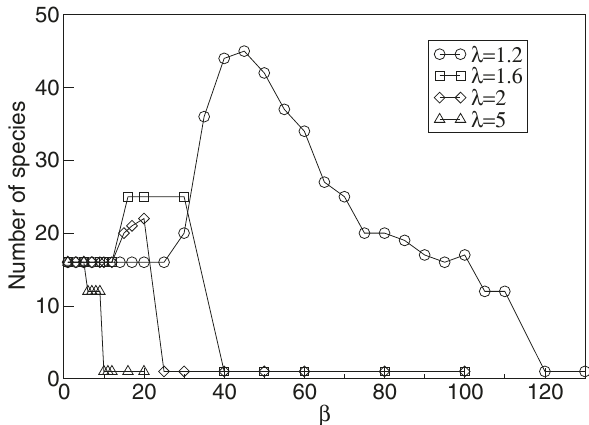
Fig. 3 Number of coexisting species as a function of the exponent β . Circles are for λ = 1.2, squares for λ = 1.6, diamonds for λ = 2, and triangles for λ = 5. Dimension of phenotype space is d = 2, and σ α = 0.5. Species are counted after 10 7 generation and after clustering of populations of similar phenotypes using a merging distance of Δ x species = 10 − 1 (see second section of